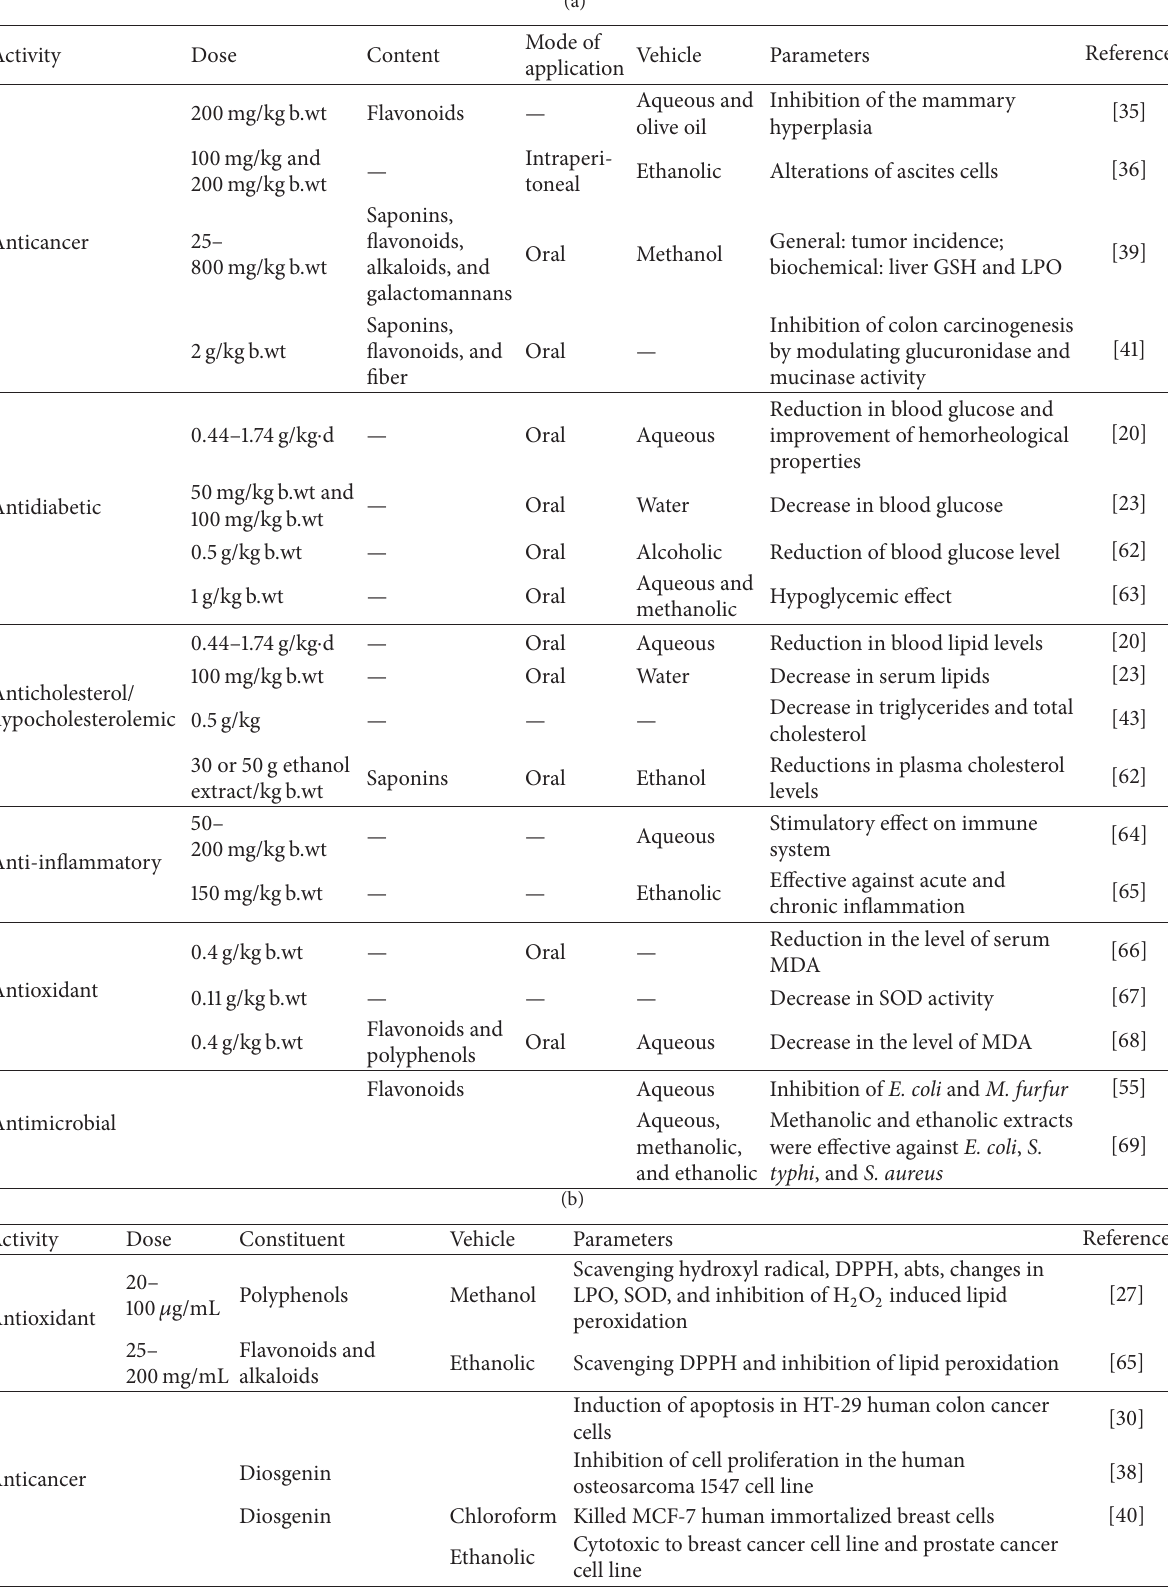
Table 1: (a) Different pharmacological activities in vivo . (b) Different pharmacological activities in vitro